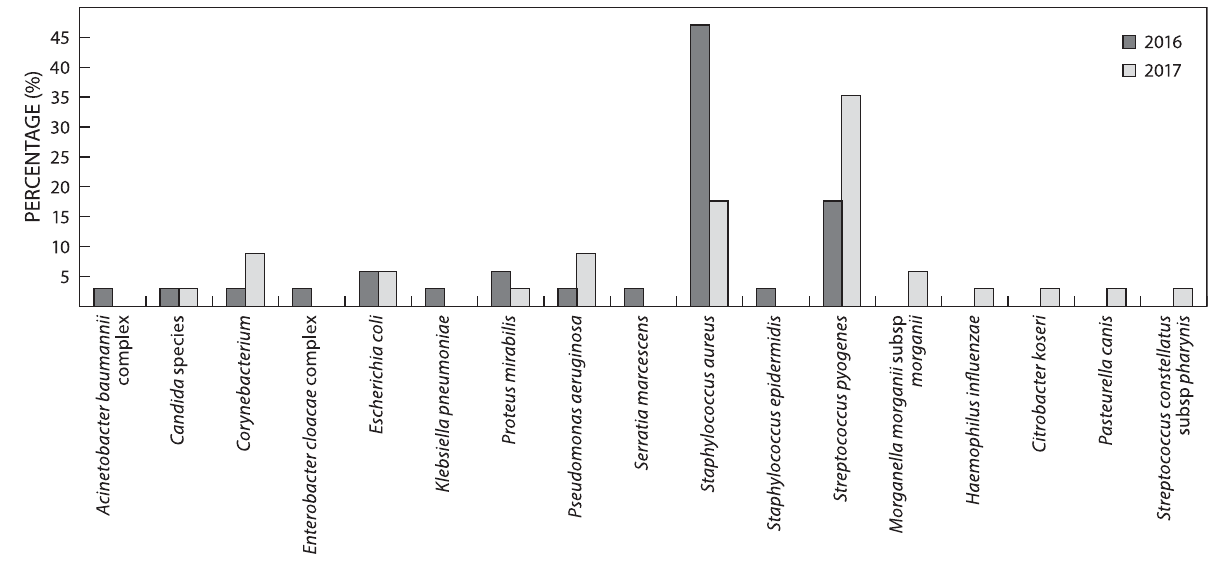
Figure 1: Percentage of pathogens isolated from super fi cial pus swabs, not reported as mixed growth or skin contamination, taken in emergency centres and processed in the National Health Laboratory Service, Department of Pathology, Division of Microbiology, Groote Schuur Hospital during 2016 and